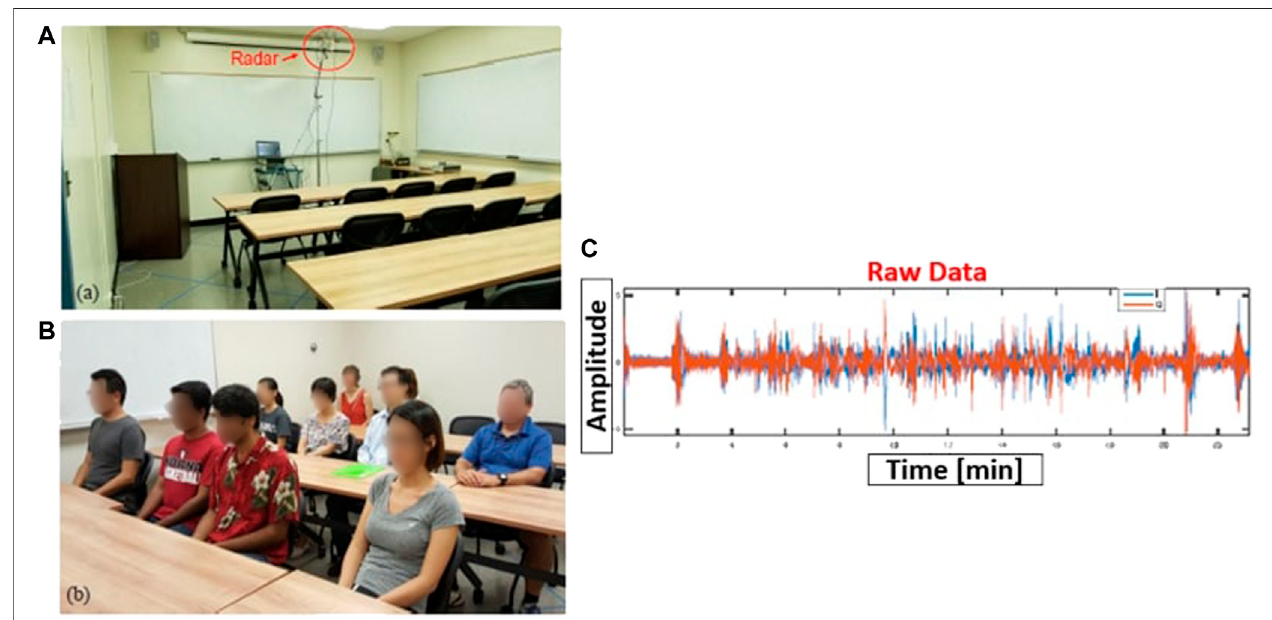
FIGURE8| Radar-based subjectpresencedetectionandcount. Experimental setupforradarmeasurementinaclassroom, (A) , fi lledwithsubjectsfortesting, (B) , and raw radar data used for assessing presence, (C) . From Yavari et al. (2018).